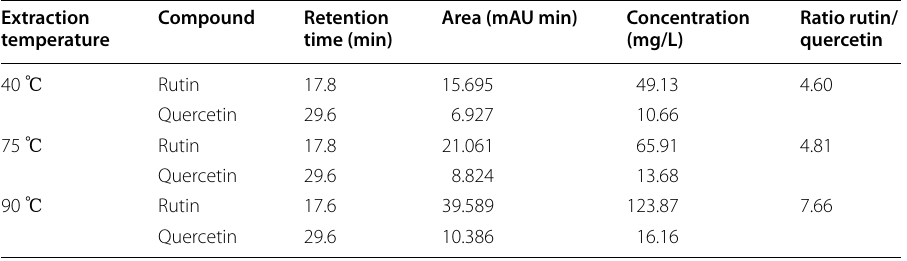
Table 3 Concentration of rutin and quercetin in Flos Sophorae extract obtained by different extraction